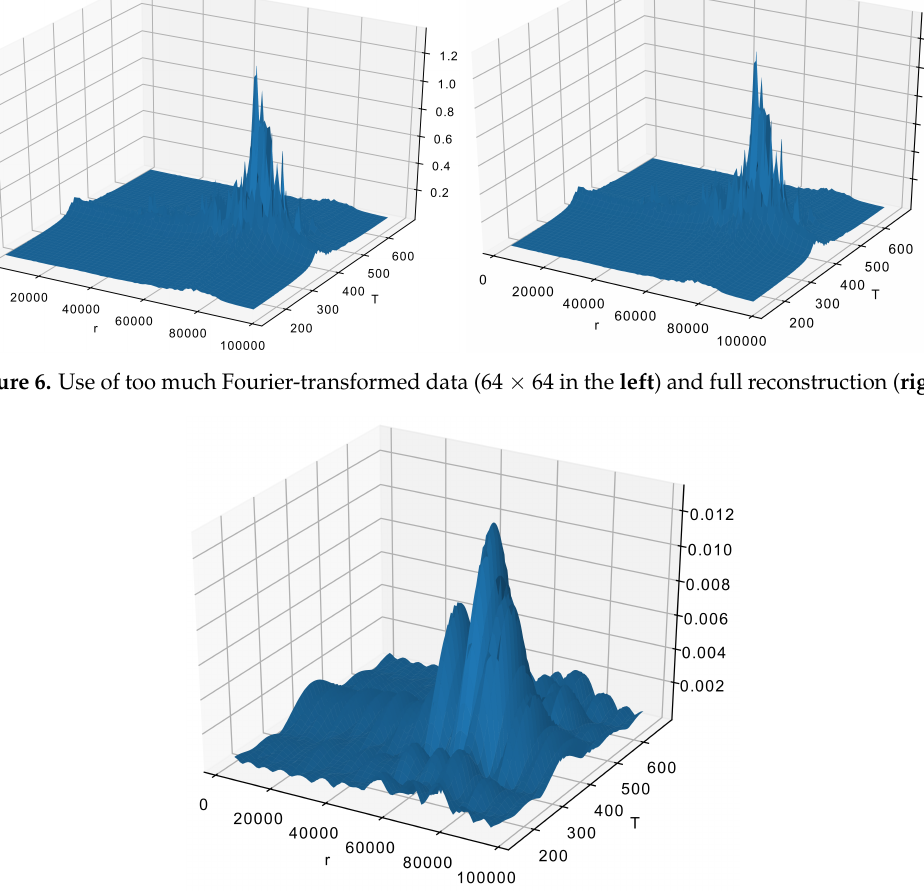
Figure 7. Good selection of data for smoothing, 16 in r , 4 in T